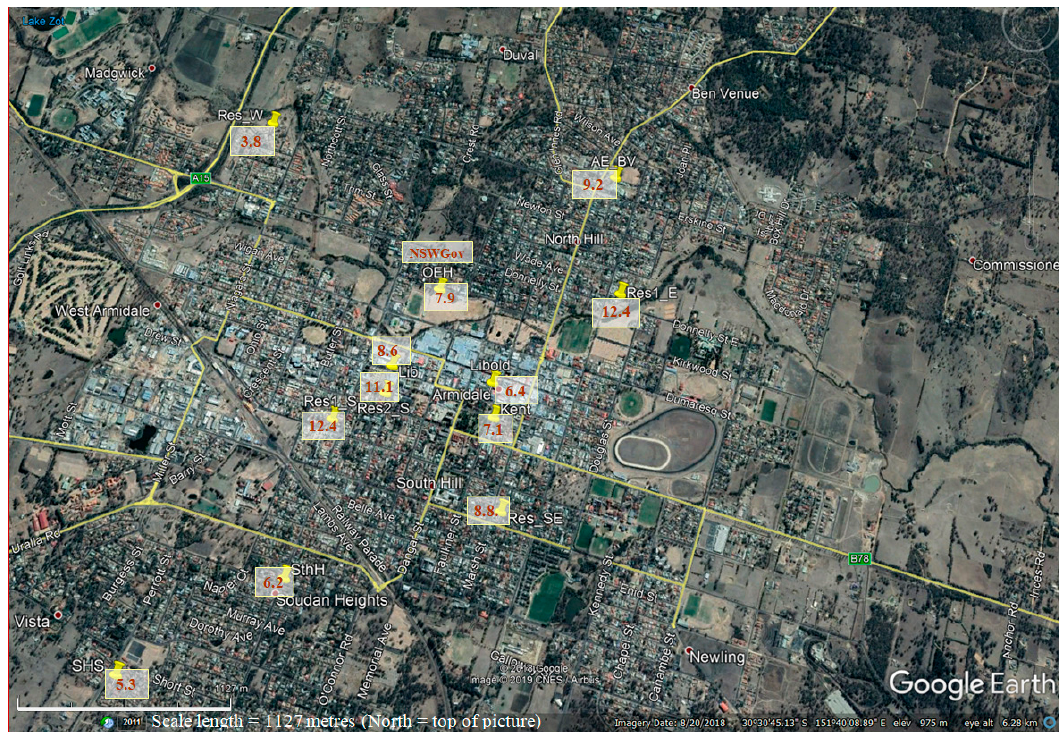
Figure 1 . Measurement locations (yellow markers), site names (white text) and estimated average annual PM2.5 exposure from wood smoke, Armidale, 2017–2018.